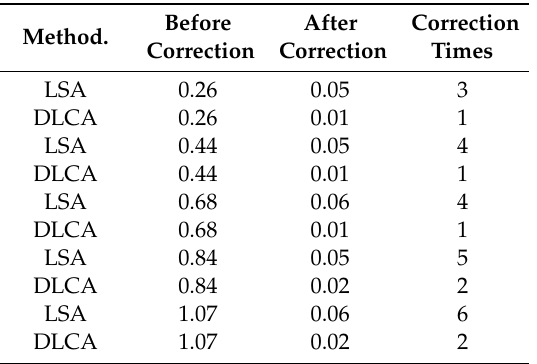
Table 3. Comparison of correction results for di ff erent algorithms.